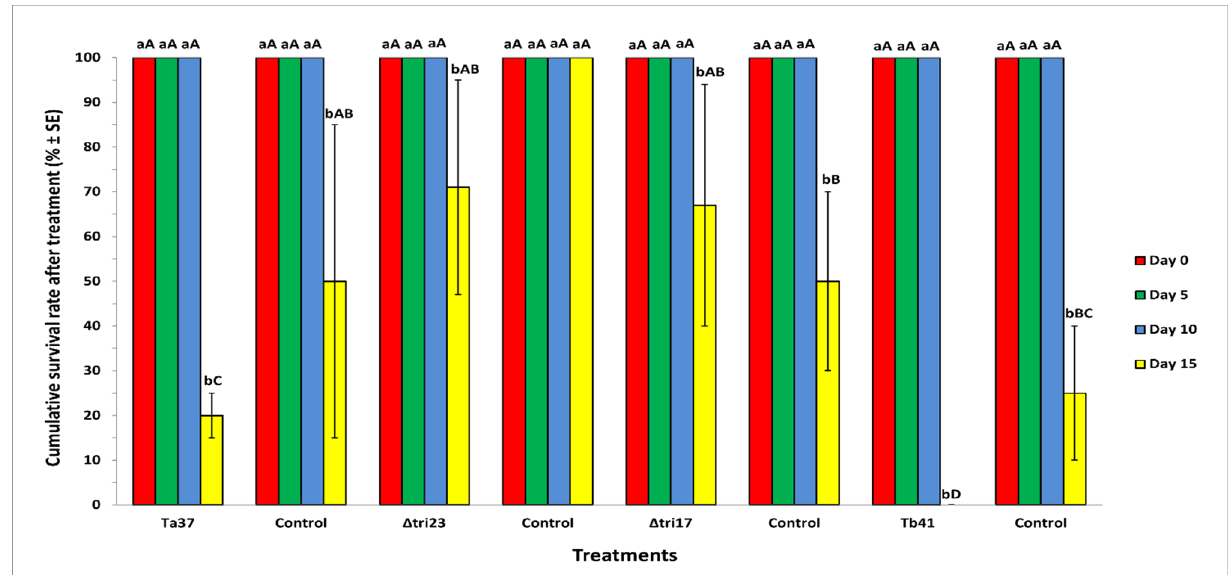
Figure 2. Mortality of A. obtectus exposed to beans sprayed with Trichoderma strains during the 15 days. Global comparisons of mortality rate for all treatments (Wilcoxon-Gehan = 13.631; df = 7,141; p = 0.050). Pairwise comparison among all treatments (Wilcoxon-Gehan). Different lowercase letters indicate significant differences among days within each Trichoderma strain or its control; ( p < 0.05) . Different capital letters indicate significant differences among treatments within the same day of evaluation; ( p < 0.05).